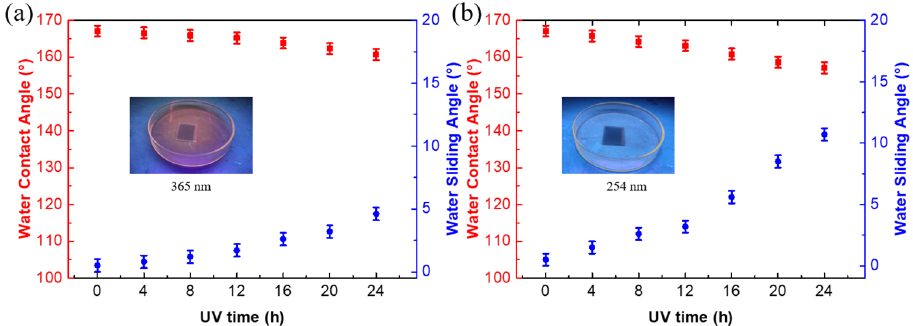
Figure 8. The changes of the WCA and WRA of the modified film after UV irradiation with a ( a ) 365 nm and ( b ) 254 nm UV lamp.